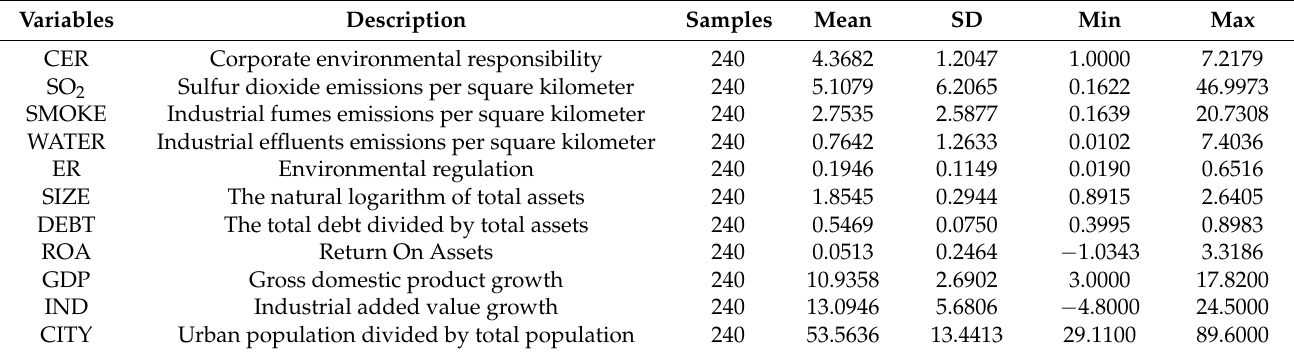
Table 3. Description of